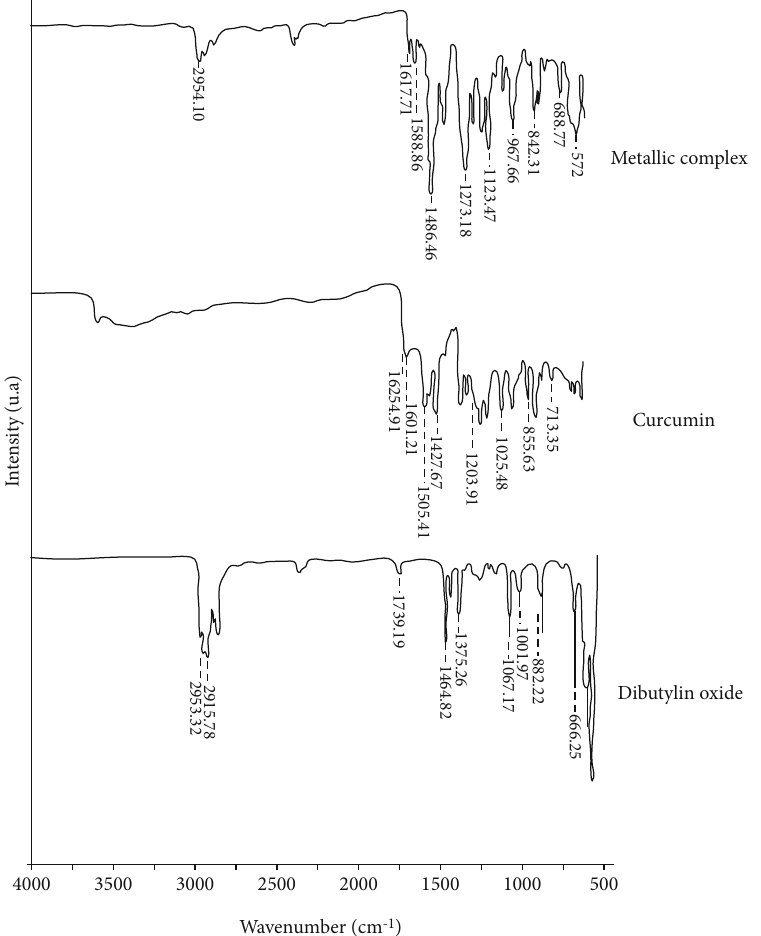
Figure 2: FTIR spectra of curcumin, dibutyltin oxide, and the obtained Sn-metallic